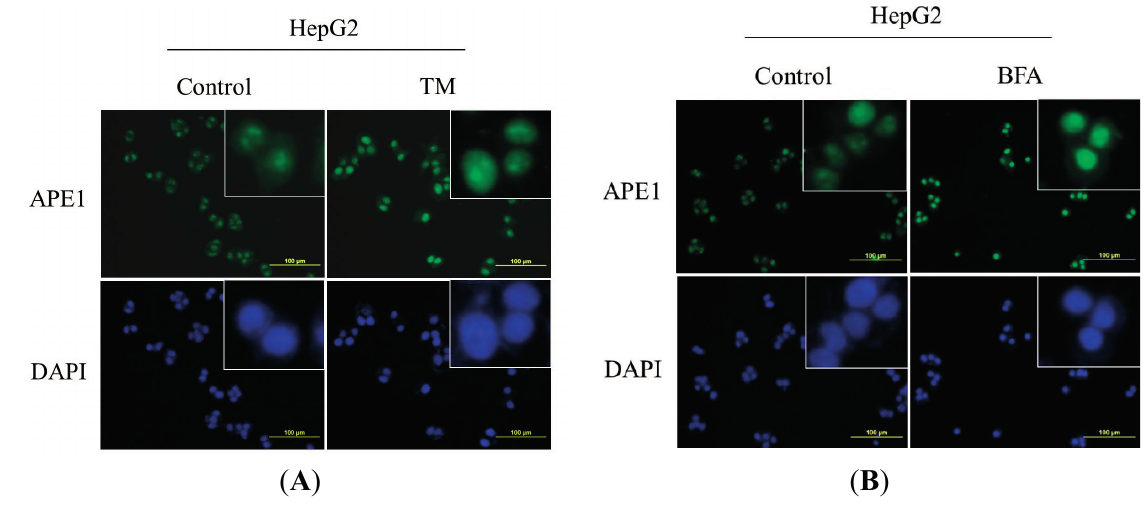
Figure 3. Nuclear localization of APE1 during ER stress. ( A , B ) Nuclear localization of APE1 in response to ER stress in HepG2 cells. The cells were treated with 2.5 μ g/mL tunicamycin or 1 μ g/mL BFA, and the localization of APE1 was determined by using immunofluorescence staining. Scale bar: 100 μ